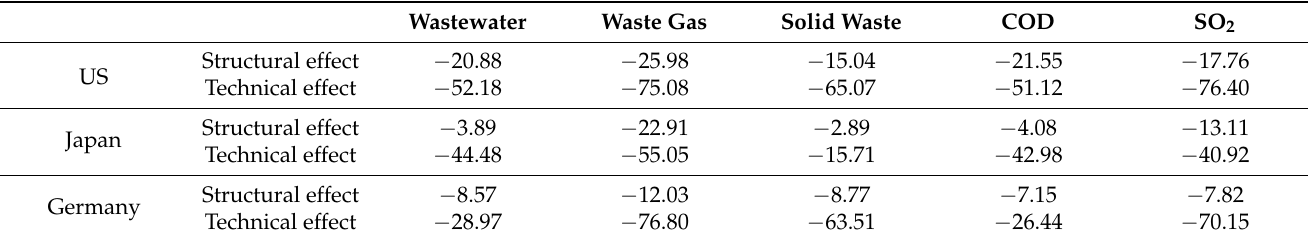
Table 3. The effect of decomposition of revised PTT (unit: